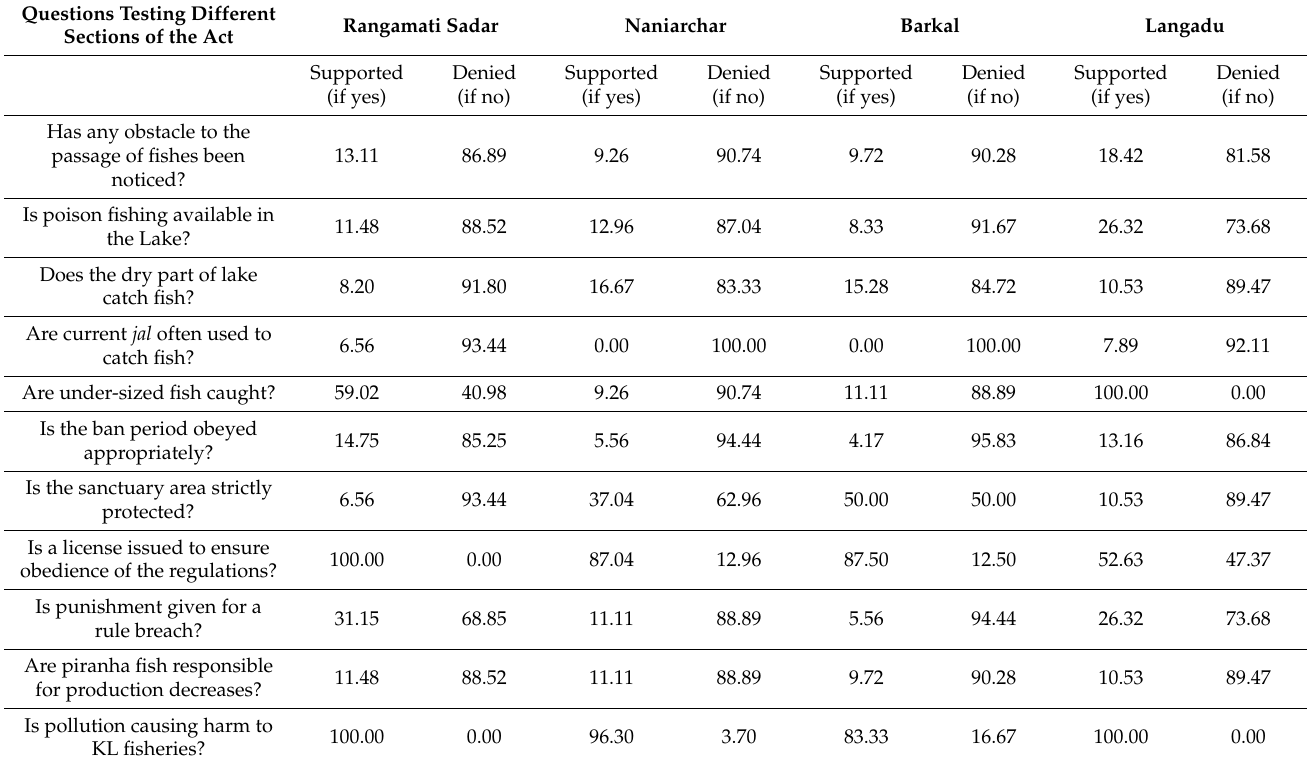
Table 7. Testing different sections of the Protection and Conservation of Fish Act